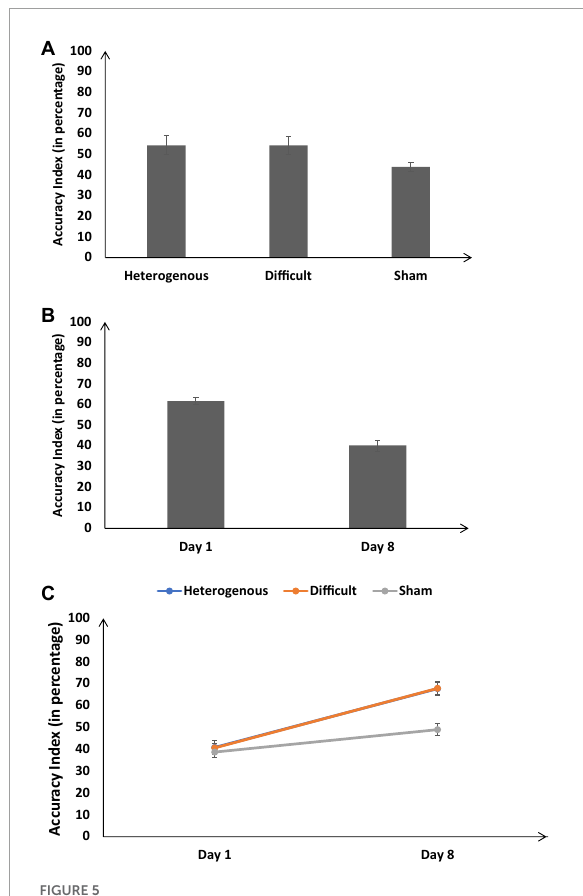
FIGURE5 (A) The accuracy index (in percentage) across different training conditions. (B) The accuracy index (in percentage) on Day 1 and Day 8. (C) The accuracy index (in percentage) across different training conditions on Day 1 and Day 8. The error bars show 95% CI around point